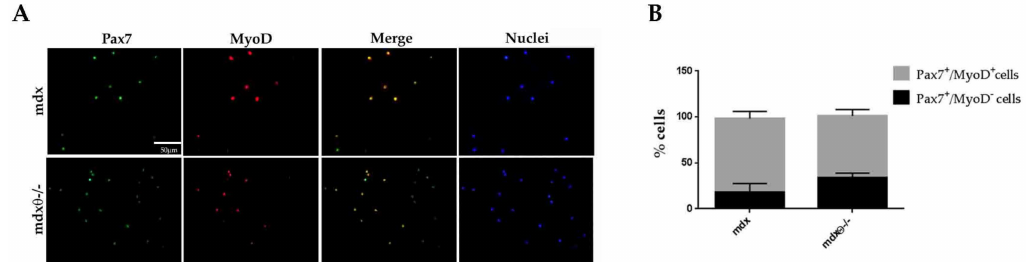
Figure 4. ( A ) Representative image of Pax7 (green) and MyoD (red) immunofluorescence of SCs, isolated from mdx and mdx θ − / − muscle and cultured for 62 h. Nuclei were counterstained with Hoechst (blue) (bar = 50 µ m). ( B ) Percentages of Pax7 + / MyoD − and Pax7 + / MyoD + cells over the total number of nuclei. The results are mean S D) ( n = 3 / ±